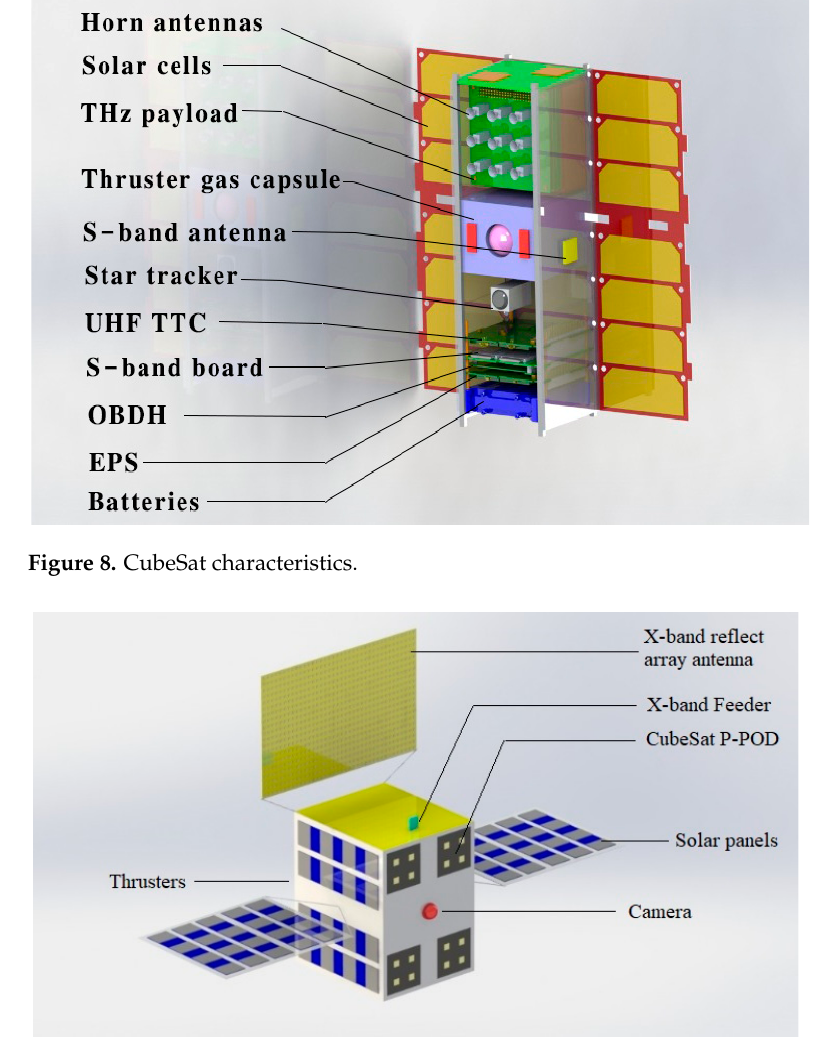
Figure 9. LOCI Microsatellite characteristics.